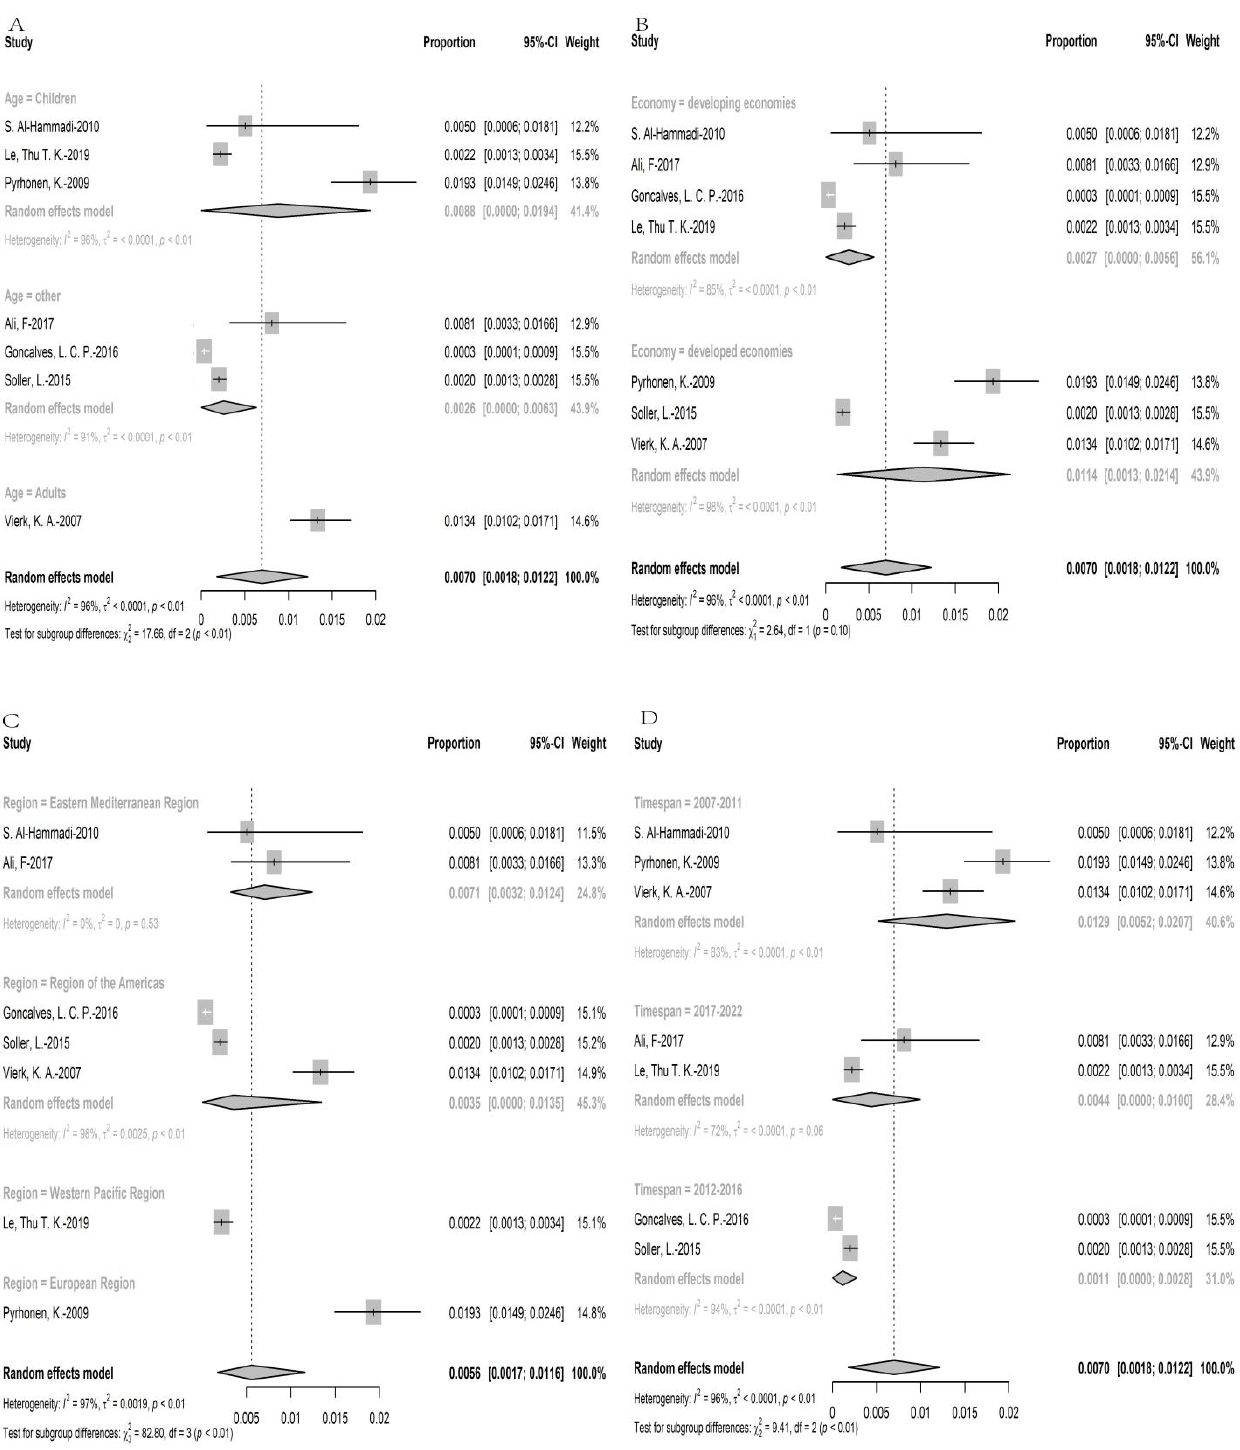
Figure 3. The prevalence of self-reported physician diagnosed wheat allergy; ( A ): the subgroup analysis for age; ( B ): the subgroup analysis for economy; ( C ): the subgroup analysis for region, ( D ): the subgroup analysis for timespan [17,18,27,37,51,56,63].